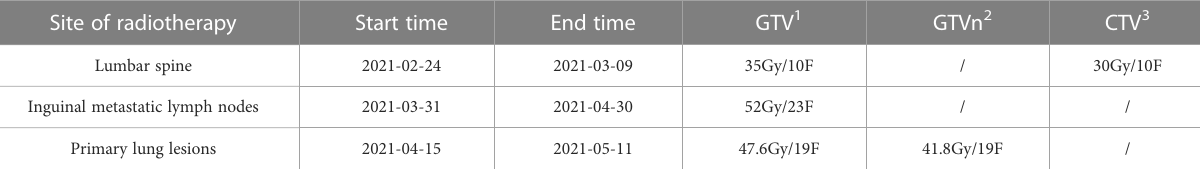
TABLE 1 Timing and plan of